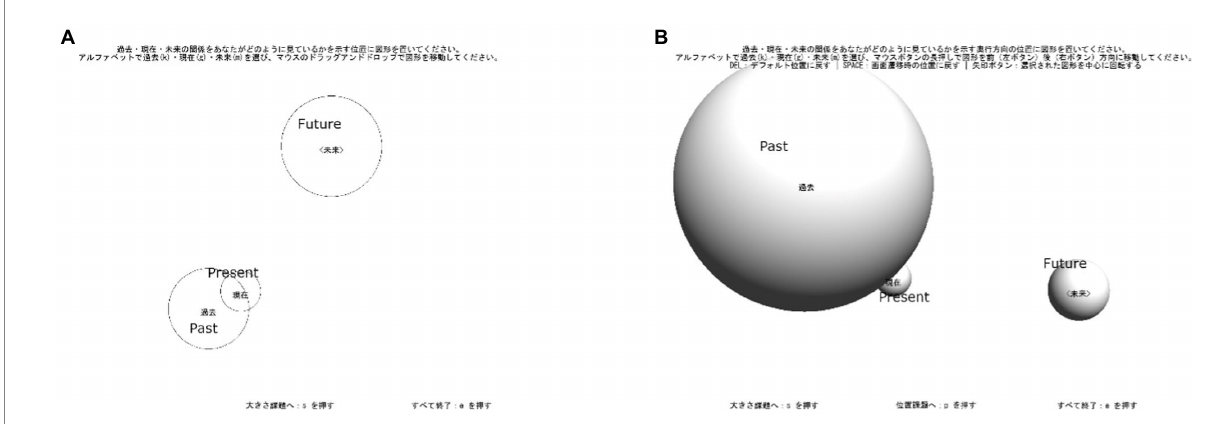
FIGURE 2 Examples of the screen images of CT (A) and ST (B) from a participant (ID: TFD0010). English descriptions were not present at the experiment.